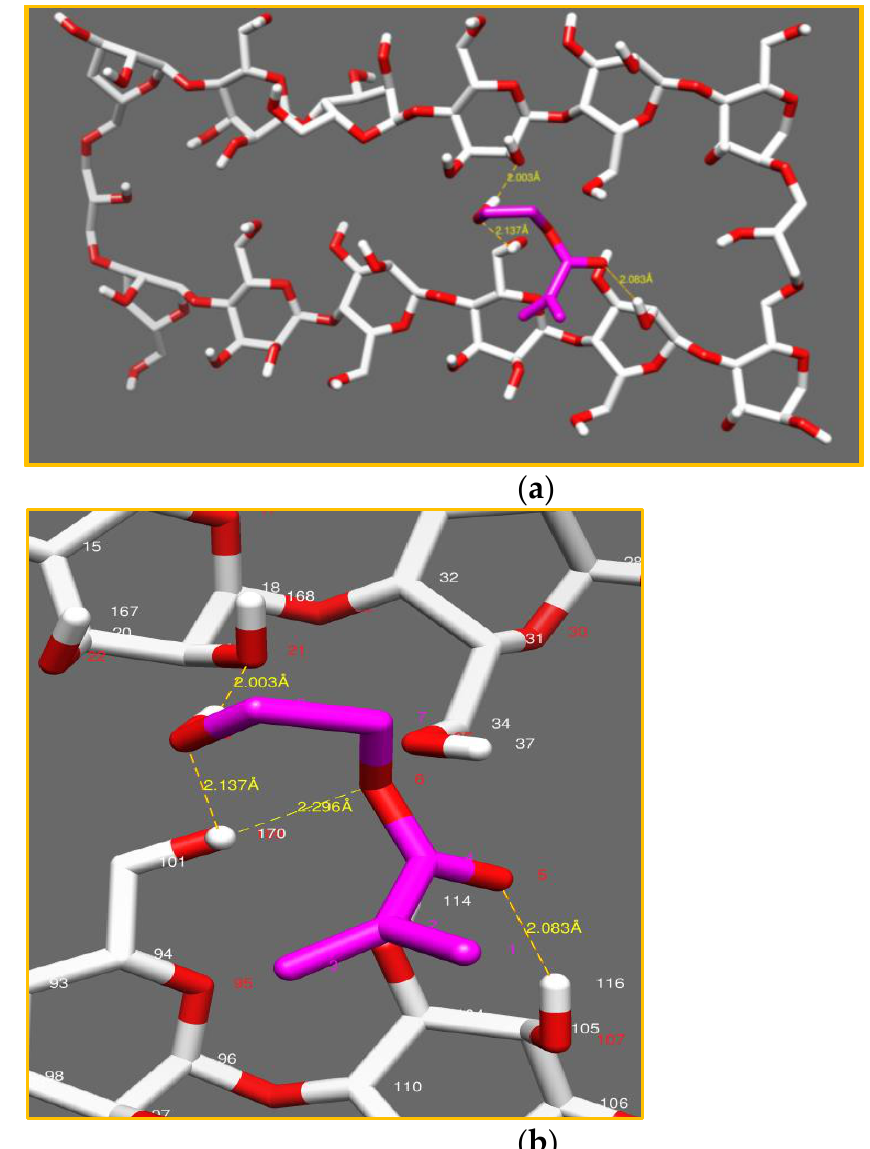
Figure 10. Conformational study of the model (cellulose network/HEMA monomer) with (ECH 1%) ( a ). Aggrandizement of interactions ( b ).